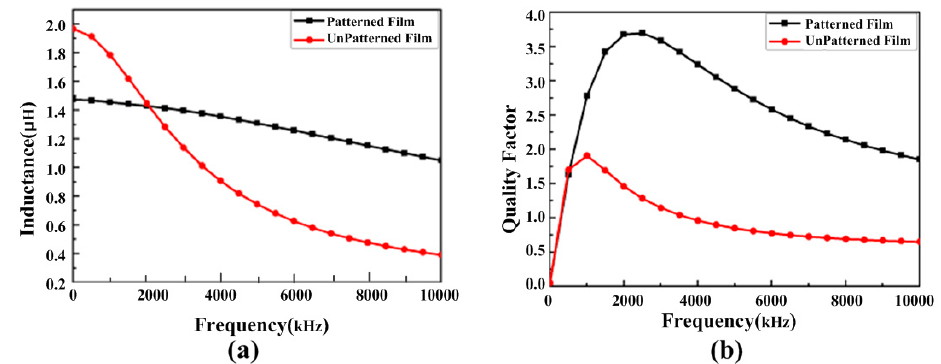
Figure 5. Simulated results for the micro-inductors with patterned or non-patterned magnetic film. ( a ) Inductance as a function of frequency; ( b ) quality factor as a function of frequency.